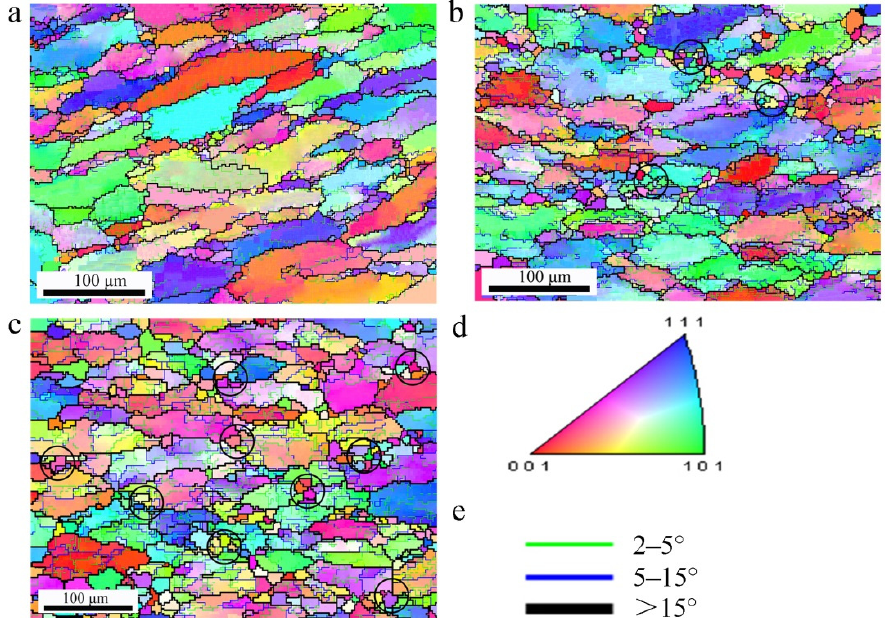
Figure 11. EBSD images of Al-Zn-Mg-Cu alloy in various deformation conditions: ( a ) 380 ° C/0.1 s − 1 , ( b ) 410 ° C/0.1 s − 1 , ( c ) 440 ° C/0.01 s − 1 , ( d ) Inverse pole figure (IPF), ( e ) representation of different color lines used to identify the boundaries with different misorientation angles in ( a – c ).